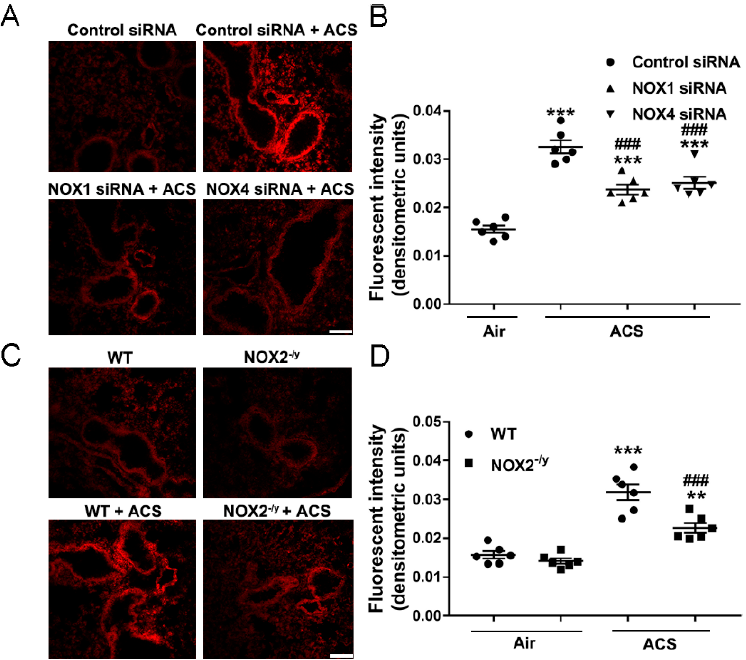
Figure 3. Knockdown of NOX1, NOX2, or NOX4 significantly attenuated ACS induced ROS production in the mouse lung . Mice were exposed to CS or filtered air for 1 h and harvested at 6 h. Frozen lung OCT sections from the superior lobe of the right lung were stained with dihydroethidium (DHE) for detection of ROS production. ( A , B ) Representative images and quantitative data of DHE fluorescent imaging of lung tissue sections from ACS exposed mice with or without RNAi-mediated knockdown of NOX1 or NOX4. The data indicate significantly increased ROS production in ACS exposed mice, which was markedly attenuated by RNAi-mediated in vivo silencing of NOX1 or NOX4. ( C , D ) Representative images and grouped data of DHE fluorescent imaging of lung tissue sections from ACS exposed wildtype (WT) mice and NOX2 − /y mice. The data indicate significantly increased ROS production in ACS exposed WT mice, which was markedly attenuated in NOX2 − /y mice. All data are presented as Mean ± SEM, n = 6. Scale bar, 100 µm. ** p < 0.01, *** p < 0.001 vs. air exposed control group. ### p < 0.001 vs. ACS exposed